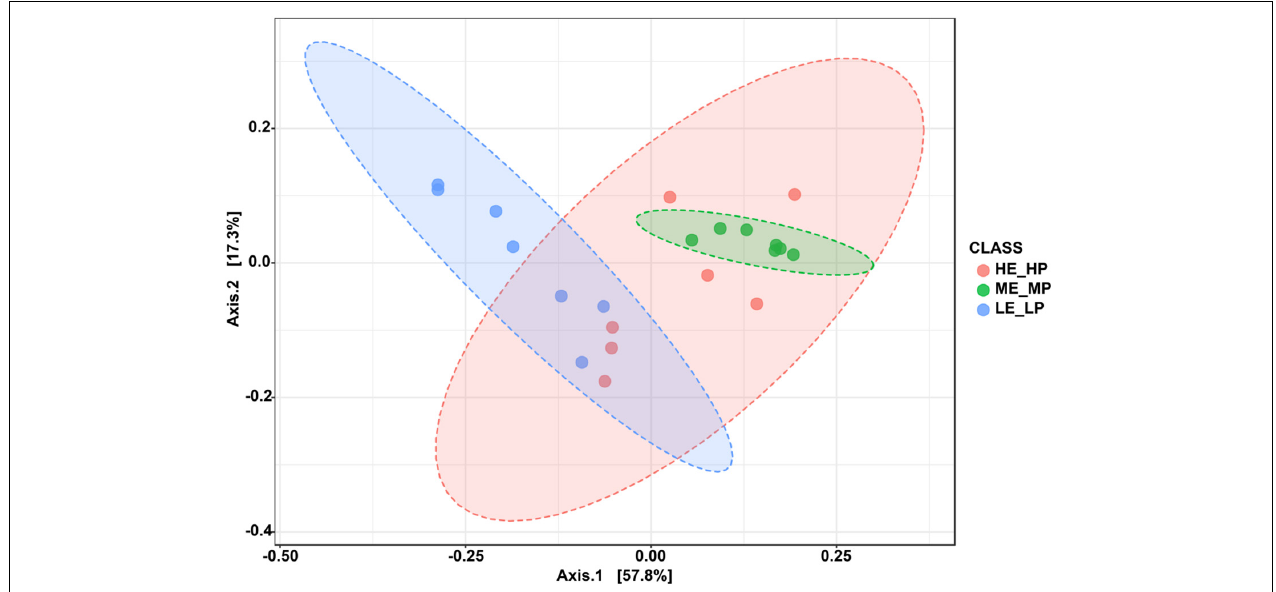
FIGURE 3 | Principal coordinate analysis of bacteria beta diversity at species level among the HE_HP cows, ME_MP cows, and LE_LP cows.